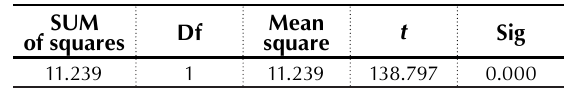
Table 10. Variance analysis, t -test for relationship between the implementation of